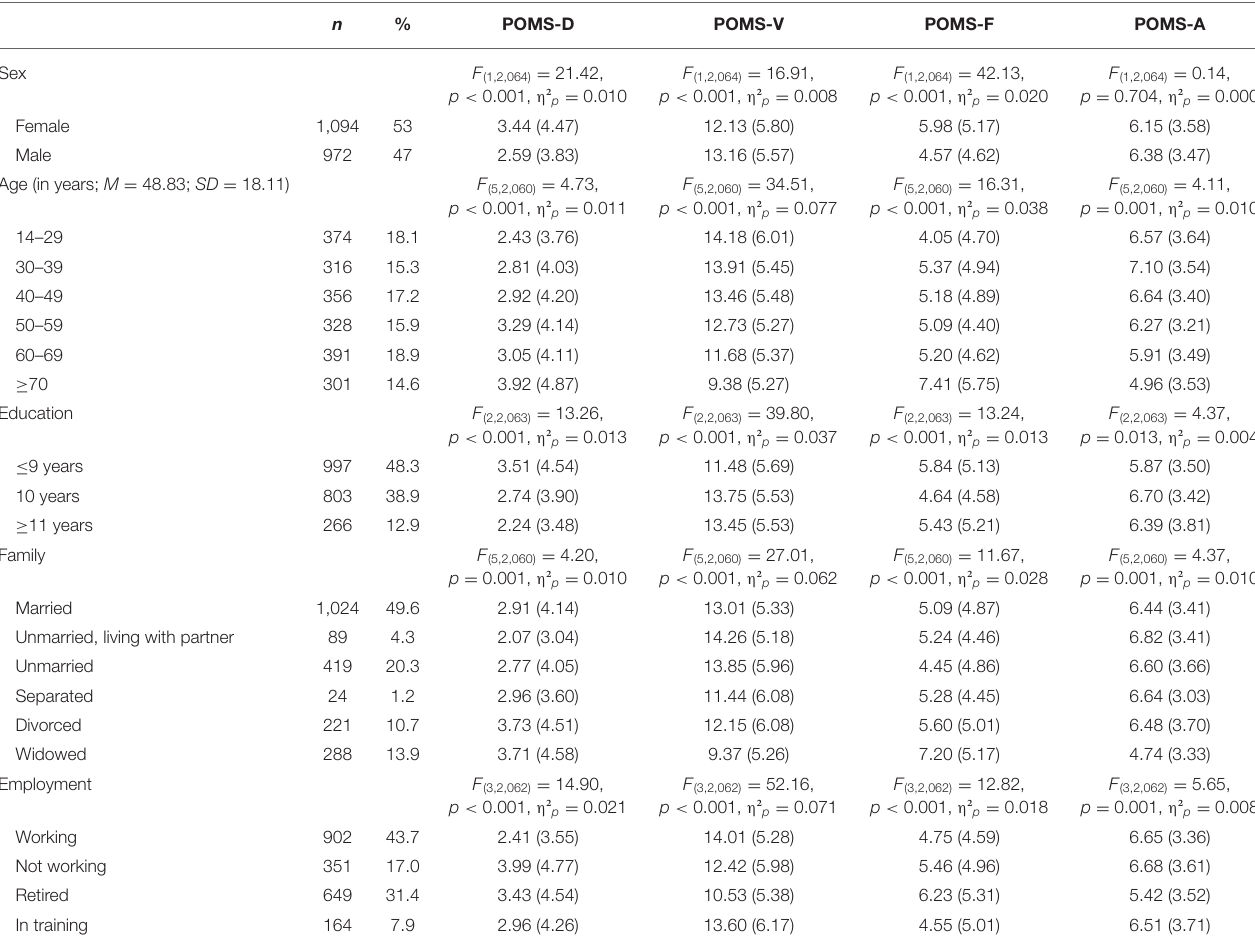
TABLE 1 | Sample description with group comparisons for the POMS-16